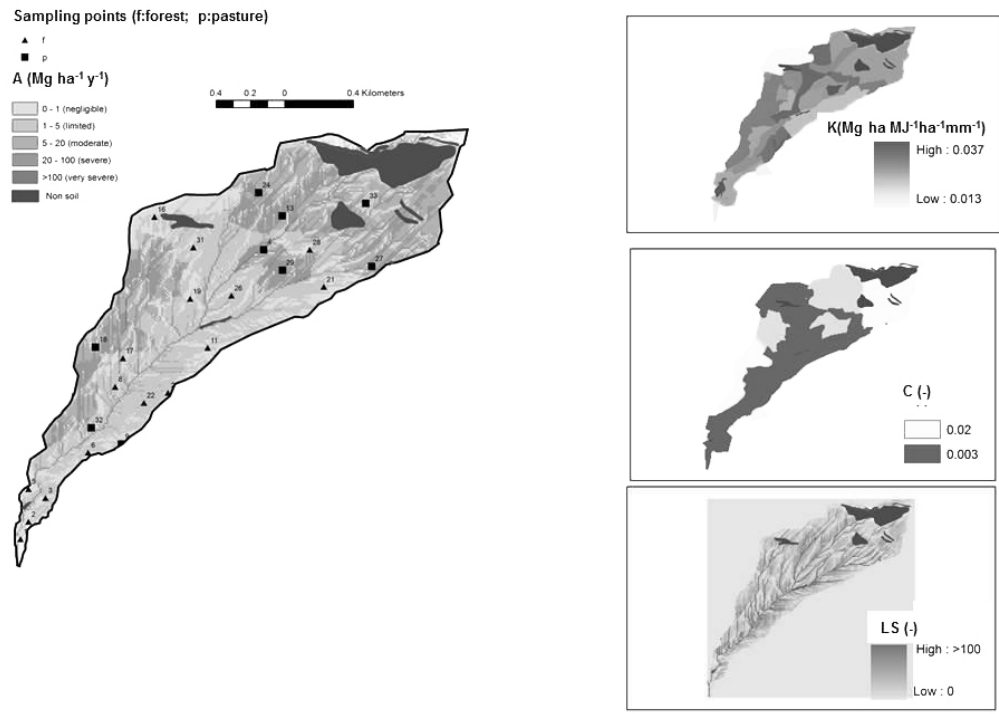
Figure 4. Map of RUSLE input factors and